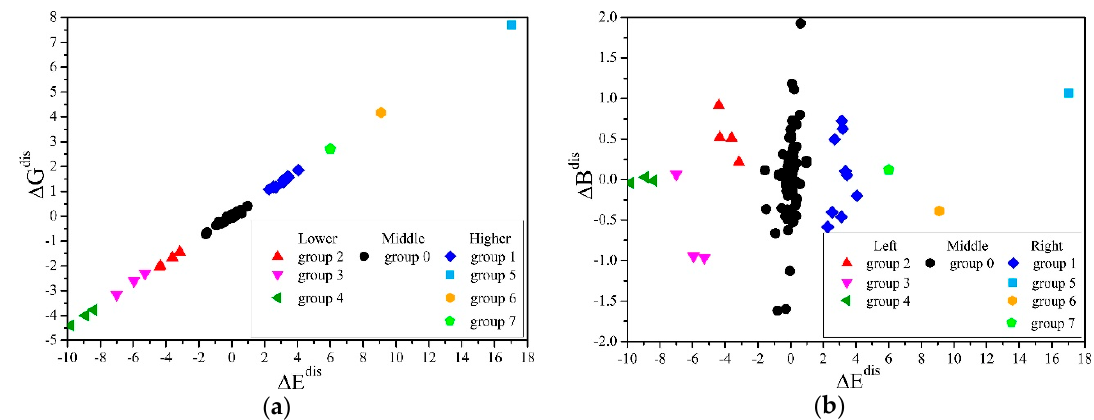
Figure 4. Mean-shift clustering for the differences of the elastic moduli in generated structures. ( a ) The projection of points in the S system and the clustering results on the ∆ E dis - ∆ G dis plane, which shows the linear correlation of ∆ E dis and ∆ G dis . ( b ) The projection of points in the S system and the clustering results on the ∆ E dis - ∆ B dis plane, which shows that group 0 contained the most structures, and that there was no linear relationship of ∆ E dis and ∆ B dis .